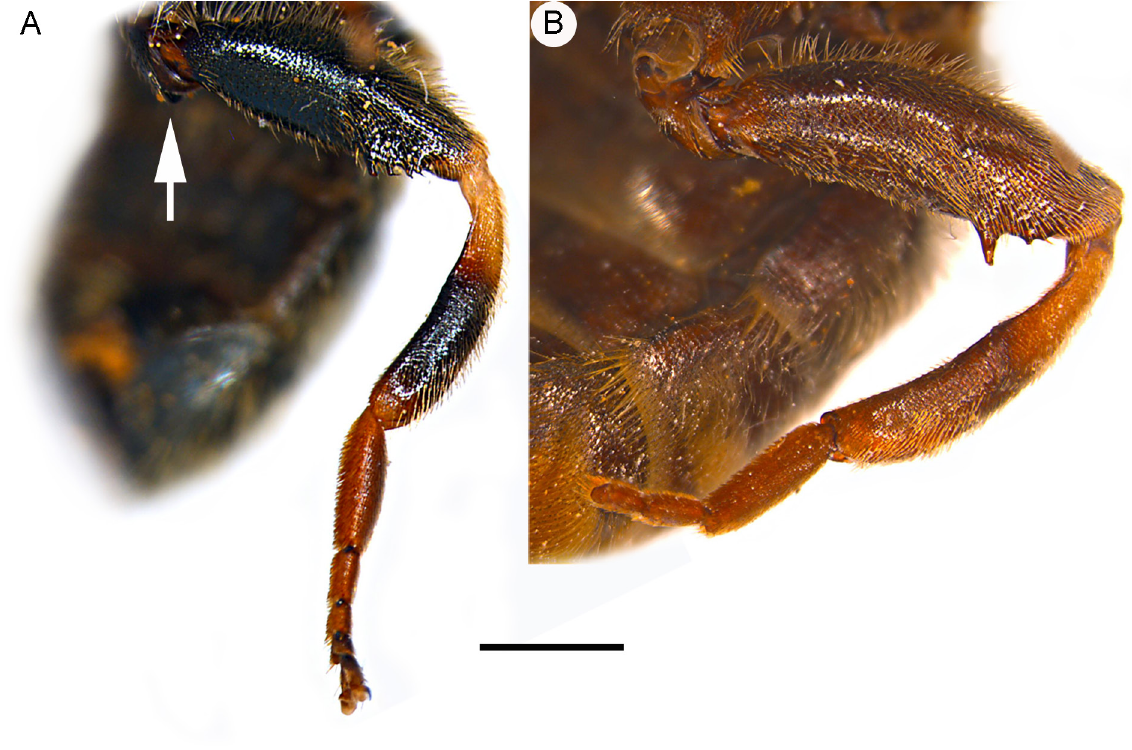
Fig. 8. Male metaleg, lateral view. A . Merodon funestus (Fabricius, 1794) (CWM; FSUNS 10347). B . M. vittatus Vujić & Likov sp. nov., holotype (NBCN; FSUNS ID 04085). Calcar on metatrochanter marked with arrow. Scale bar = 2